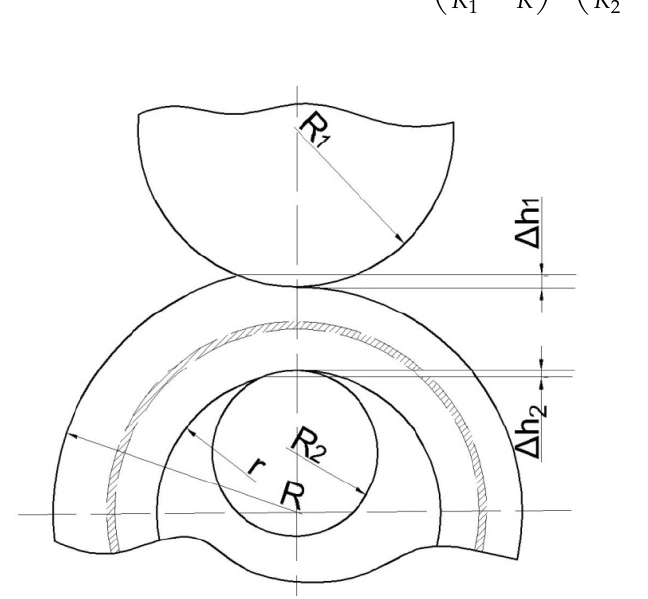
Figure 9. Schematic of the bimetallic ring blank in the rolling process.